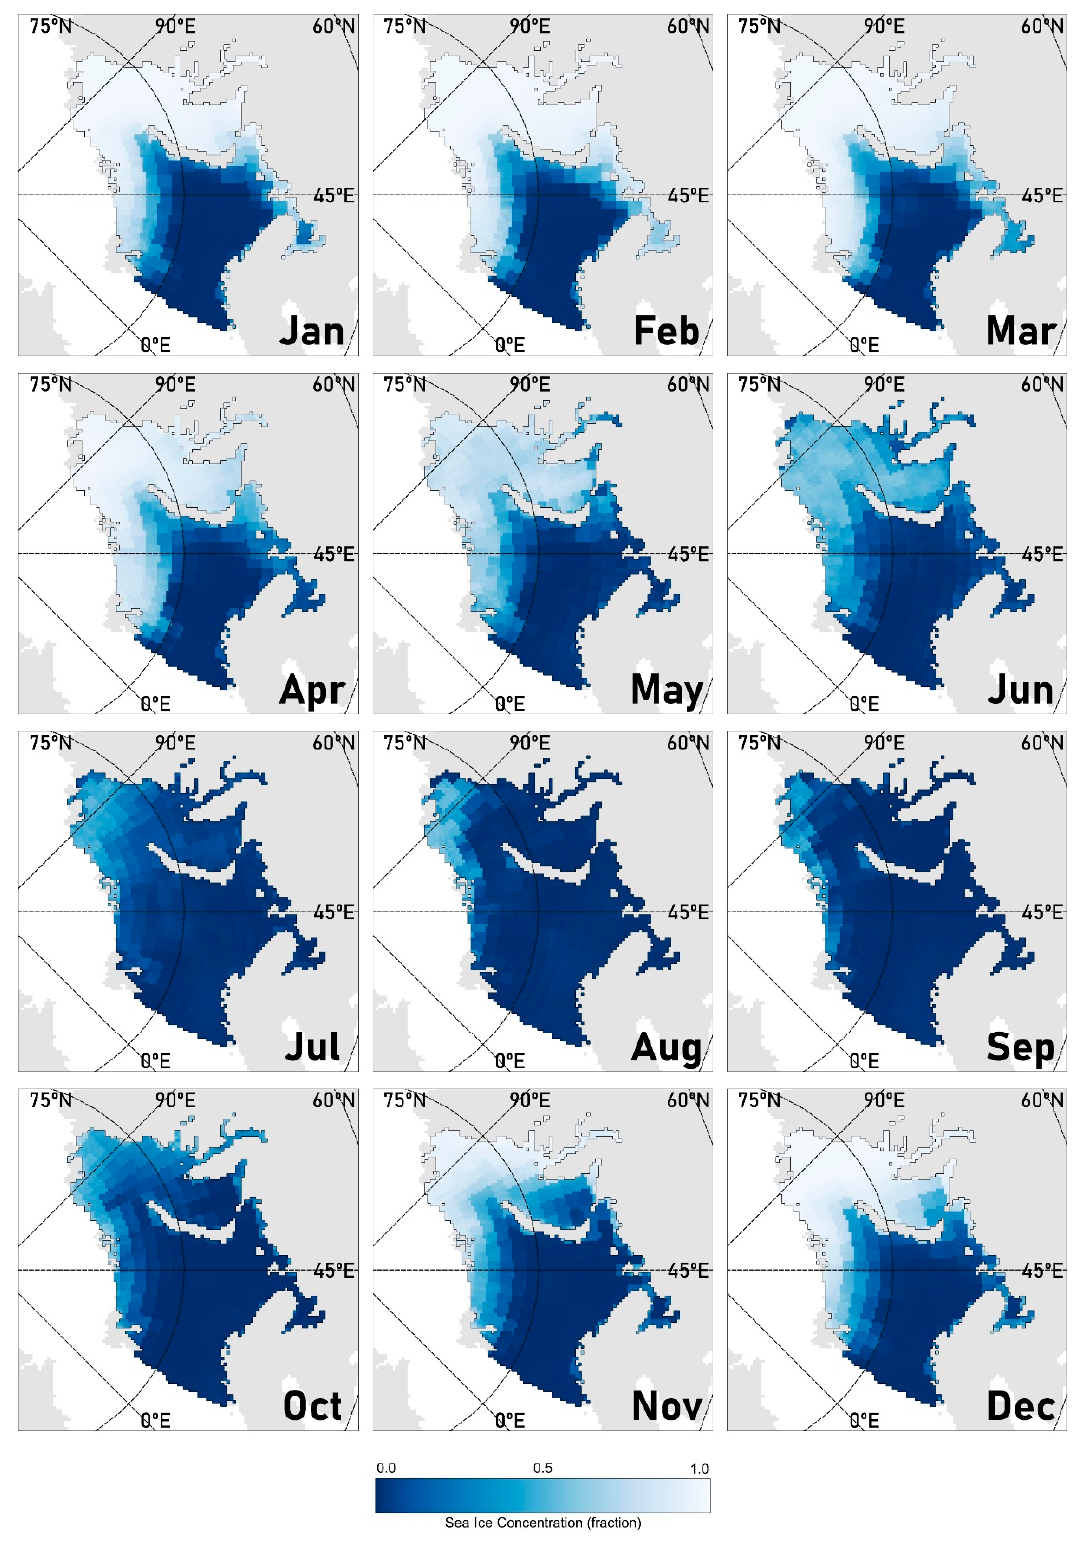
Figure 8. Monthly averages of sea ice concentration predicted by the DNN with BMA2 ensemble for the Kara and Barents Seas during 2006–2016.